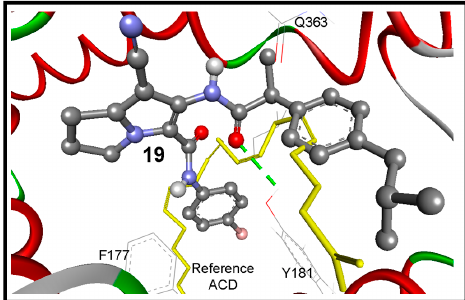
Figure 11. The binding mode of the interaction of compound 19 (ball and stick) into the target enzyme (5-LOX; pdb code: 3o8y). It bounds with Tyr181 by one hydrogen bond (green dotted lines) within RMSD of 3.24 Å from the reference ACD (yellow sticks).